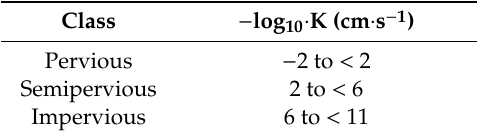
Table 2. Permeability classes, modified after Bear [29].